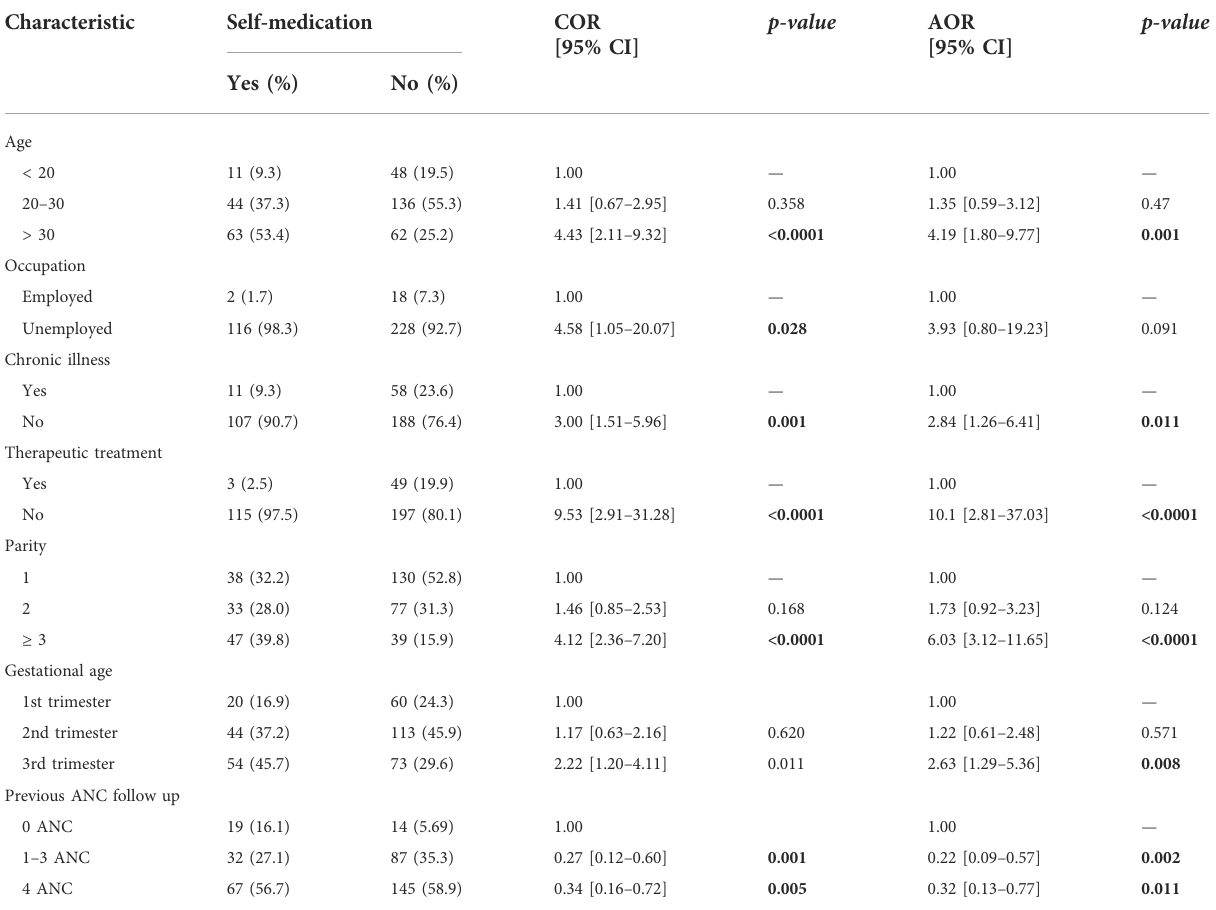
TABLE 3 Factors associated with modern drug self-medication of study participants, 2019 ( n =